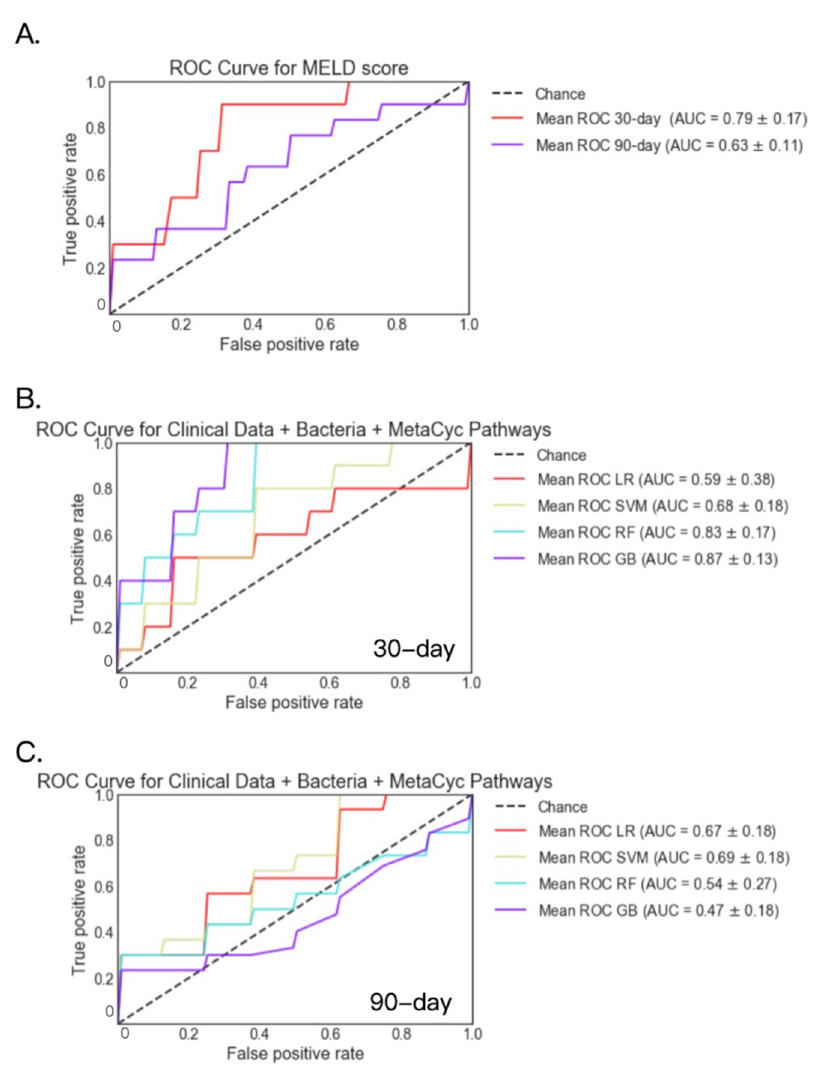
Figure 3. 30- and 90-day mortality prediction using fecal bacteria, MetaCyc pathways and clinical data in patients with alcoholic hepatitis. ( A ) 30- and 90-day mortality prediction using MELD score. ( B ) 30-day mortality prediction using fecal bacteria, Metacyc pathways and clinical data. Deceased group n = 8; alive group n = 65. ( C ) 90-day mortality prediction using fecal bacteria, Metacyc pathways and clinical data. Deceased group n = 13; alive group n = 40. GB: gradient boosting, LR: logistic regression, RF: random forest, SVM: support vector machine.